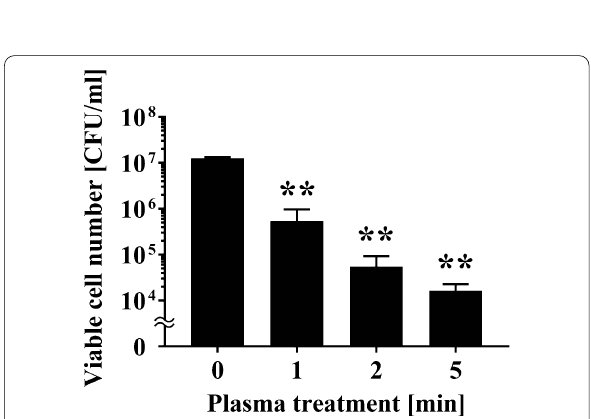
Fig. 2 Viable cell number of Aspergillus brasiliensis spotted onto an aluminium plate following APDBD treatment. Viable cell number of A. brasiliensis spotted onto an aluminium plate, expressed as CFU/ml, after different APDBD treatment times (0, 1, 2, or 5 min). Differences where p < 0.01(**) versus Control (0 min) were considered significant when verified by the non-repeated measured ANOVA followed by the Bonferroni